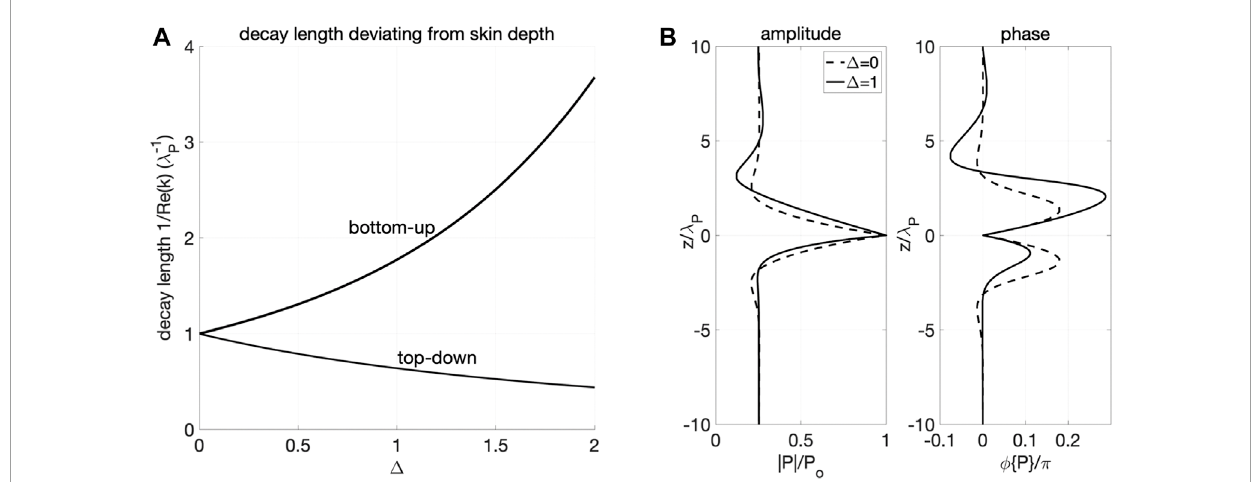
FIGURE 2 (A) Decay lengths associated to dispersion relation (4) as functions of Δ . For any frequency there are two wavenumbers k , with decay length 1 / Re ( k ) . The decay lengths are normalized by the poroelastic skin depth λ P = √ 2 c / ω which has a value of 1 for the poroelastic diffusive endmember Δ = 0. (B) Shows the magnitude (left panel) and phase (right panel) of the frequency-domain solution for pressure ̂ P ( z ) . The magnitude and phase are obtained from Eq. 5 for two Δ values. The perturbations are triggered by a harmonic pressure input at z = 0 with magnitude P o . Vertical distance is scaled by the poroelastic skin depth λ P . Other parameters used for (B) include melt bulk modulus K l = 1 GPa, shear modulus μ = 1 GPa, solid bulk modulus K s = 10 GPa, porosity ϕ = 0 . 3, and gas volume fraction in pore melt χ = 0 . 3.